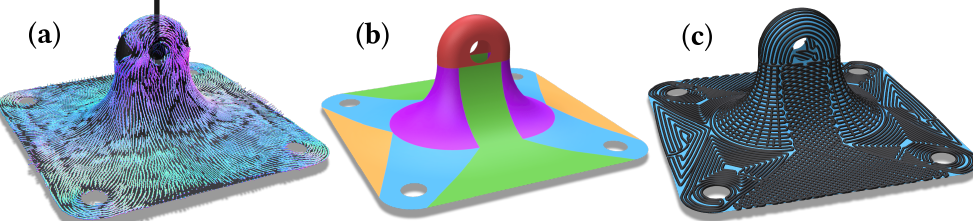
Figure 1. ( a ) Maximum principle stress vectors resulting from finite element analysis (FEA). ( b ) De- composition of part into subsurfaces. ( c ) Exemplary planned paths for all subsurfaces with d = 1 mm. Filament thickness displayed does not correspond to thickness when